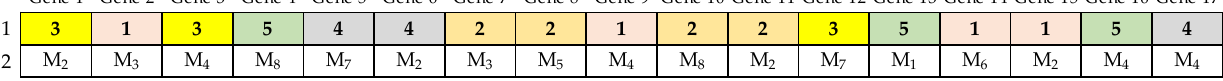
Figure 3. Illustration of an alpha chromosome. Figure 3. Illustration of a beta chromosome.